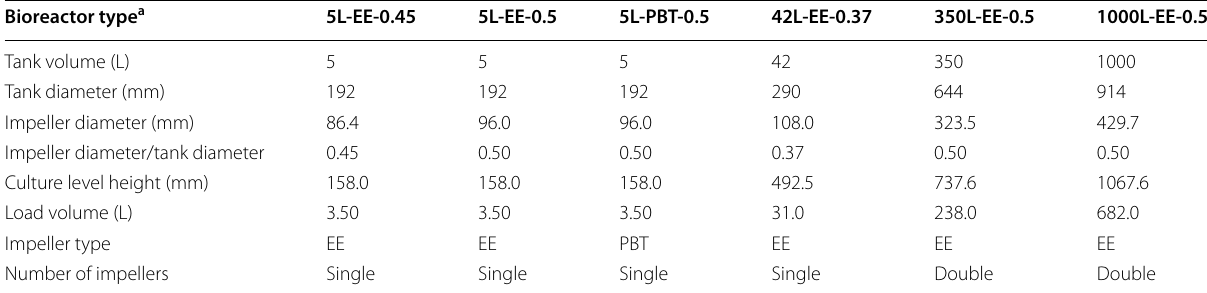
a Bioreactor type is expressed as “bioreactor volume-impeller type-ratio of impeller diameter to tank diameter”